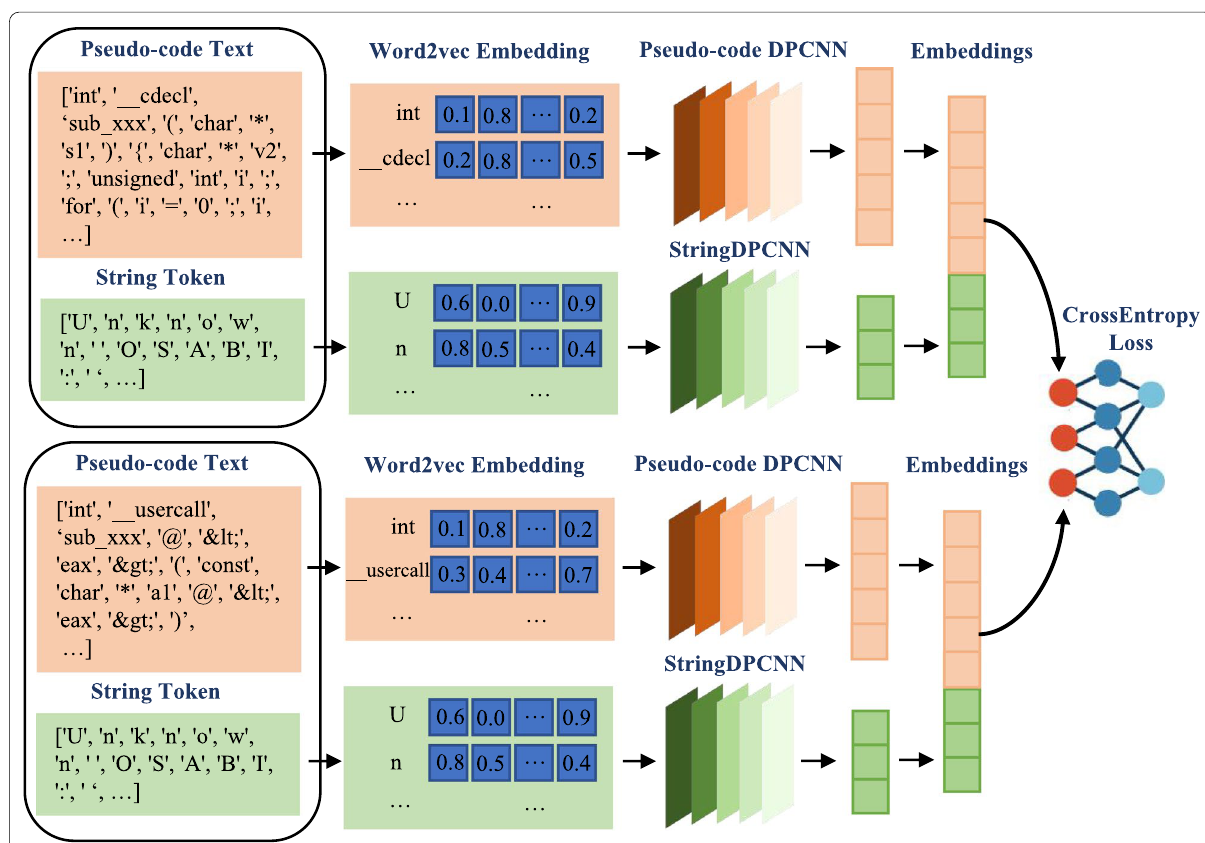
Fig. 5 The Siamese framework for function